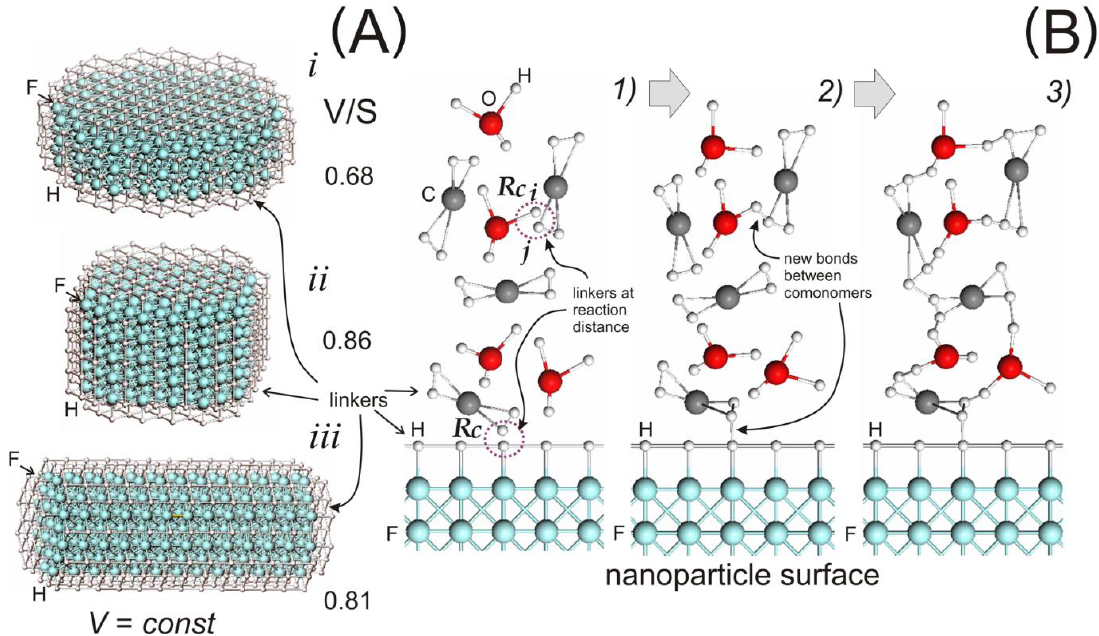
Figure 2. ( A ) Constructed nanoparticles of three types with different aspect ratios. ( B ) Curing reaction: (1) two linkers at a distance < R c , (2) new bonds formation between DGEBA-FAT3 and DGEBA-NP, (3) a fragment of the polymer network formed during the chemical reactions. All colors in this figure are the same as in Figure 1. The letters C, O, and F depict DPD beads and H linkers.